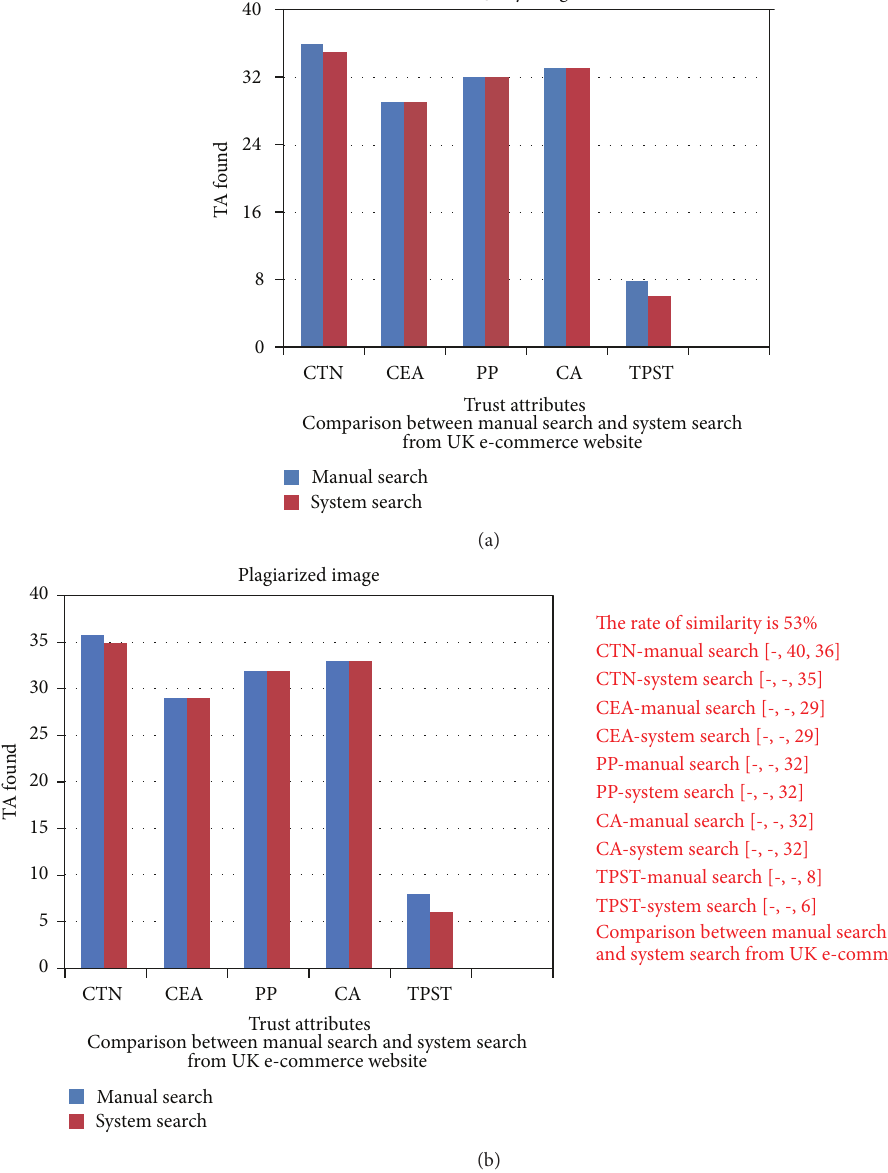
Figure 7: Plagiarism detection for one of the Modified Copy patterns which is the stealing by changing scales of image.